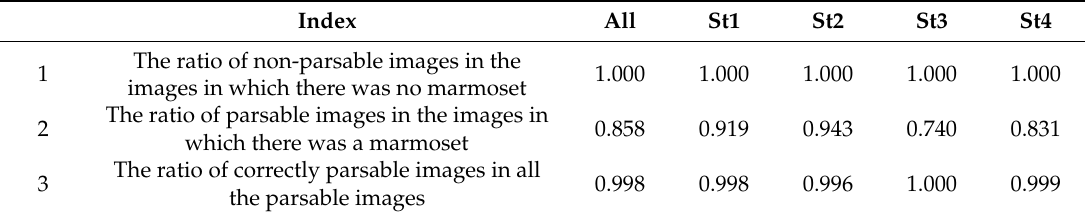
Table 1. Accuracy of the image-processing